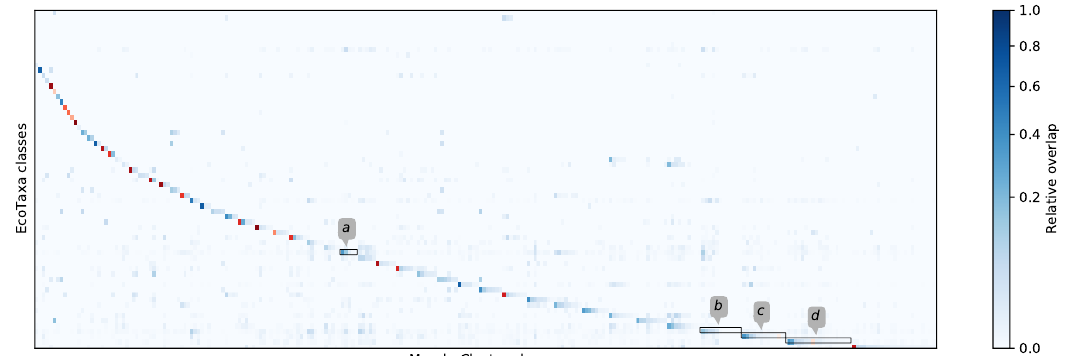
Figure 7. Correspondence of MorphoCluster and initial labels measured by relative overlap. L 0 classes are ordered by their number of correspondences, L MC classes are ordered by their corresponding L 0 class. Therefore a diagonal structure emerges. Manually established direct correspondences are colored using shades of red. The first rows are L 0 classes without a correspondence in L MC . Selected L 0 classes are annotated for further analysis: a fluffy_light, b fluffy_dark, c Trichodesmium_puff, d